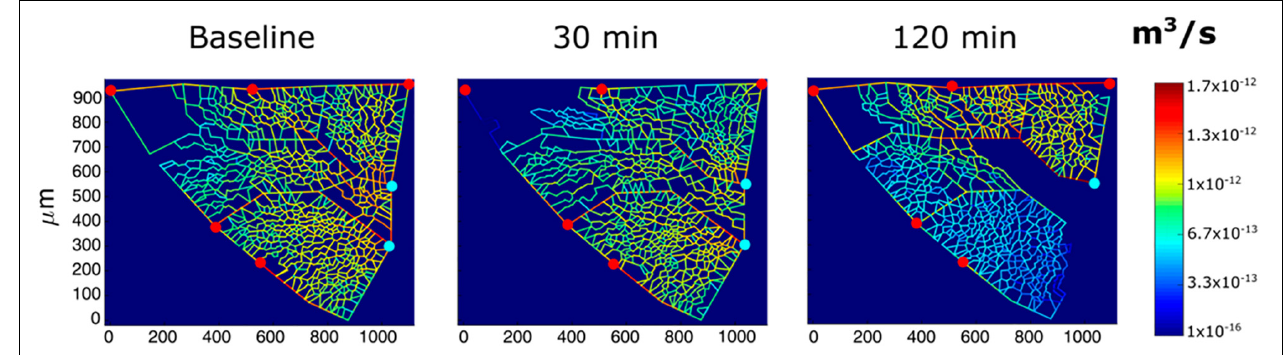
FIGURE 4 | Results from modeling of alveolar perfusion in edemagenic condition (12% O 2 exposure). Red and light blue dots identify, respectively, arteriolar accesses and venular exits. The color panels show capillary blood flow rates at different time points (baseline, 30; and 120 min) with color-coded log-scale intensity. In regions where edema develops, capillary blood flow is progressively reduced, approaching zero (from Mazzuca et al., 2019).